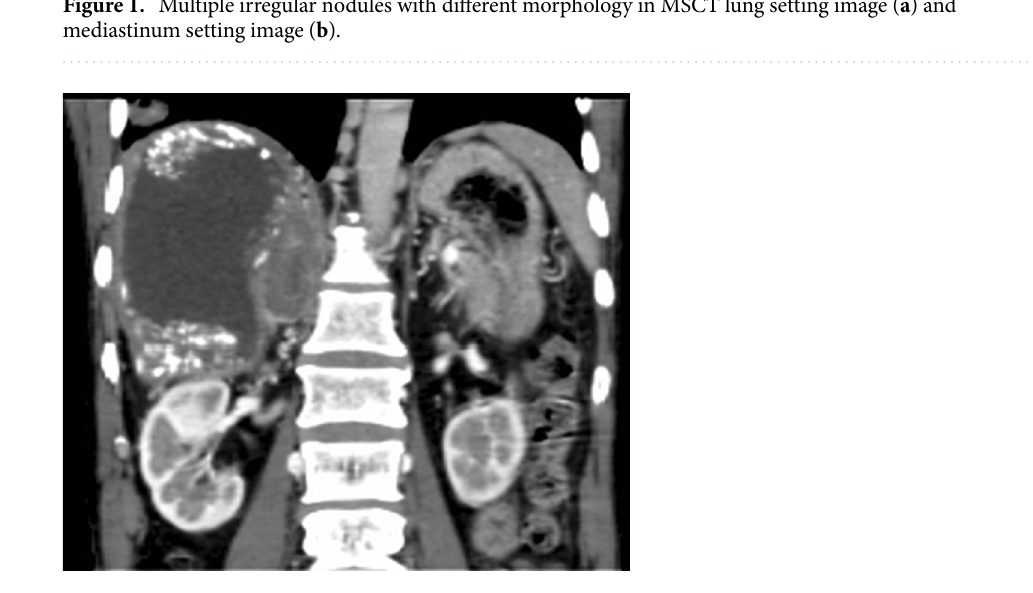
Figure 2. Hepatic AE involved the right adrenal gland. A mixed density mass in the right adrenal gland was visible in the coronal CT